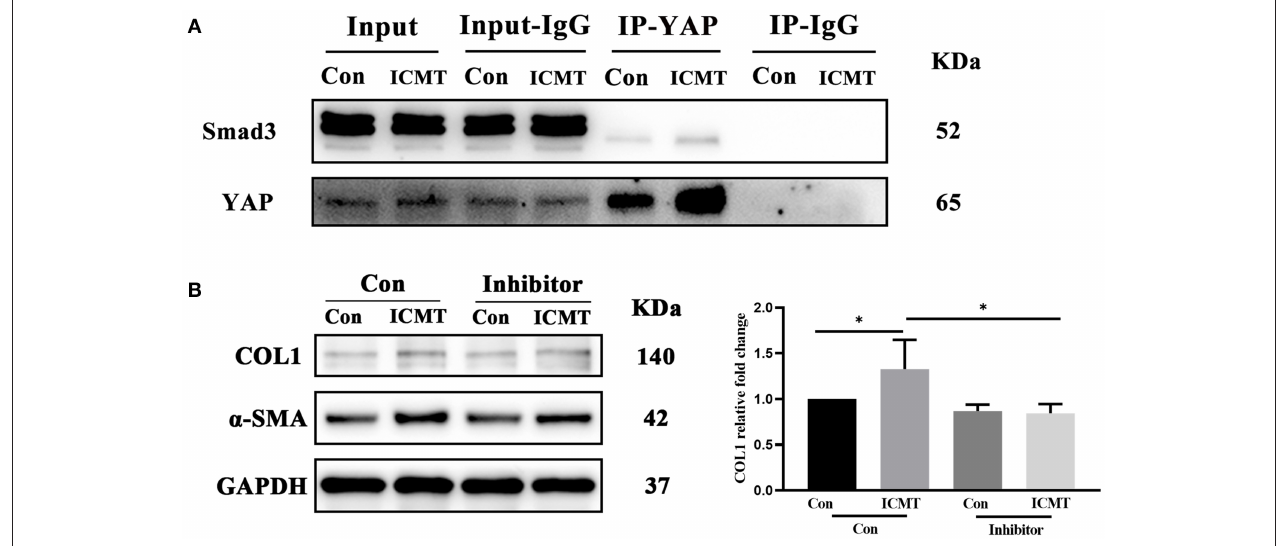
FIGURE 5 | Smad3 was bound to YAP involved in myofibroblast differentiation induced by the mechanical strain. (A) Immunoblot of the coimmunoprecipitation was performed to test if YAP binds to Smad3. HSF cultures without applying strain at 8h served as control groups. HSFs of the strain group were subjected to 10% cyclic strain at 0.5Hz for 8h. (B) Western blotting and quantitative analyses of COL1 and α -SMA in the Smad3-specific inhibitor and strain treatment groups. HSFs were transfected without (Con) or with SIS3 at 10 µ M (inhibitor). HSFs of the strain group were subjected to 10% cyclic strain at 0.5Hz for 8h. Data are presented as means ± SD of three separate experiments. * P < 0.05. Abbreviations: Con, control; ICMT, intermittent cyclic mechanical tension; IP, immunoprecipitation; α -SMA, α -smooth muscle actin; COL1, collagen type I; GAPDH, glyceraldehyde 3-phosphate